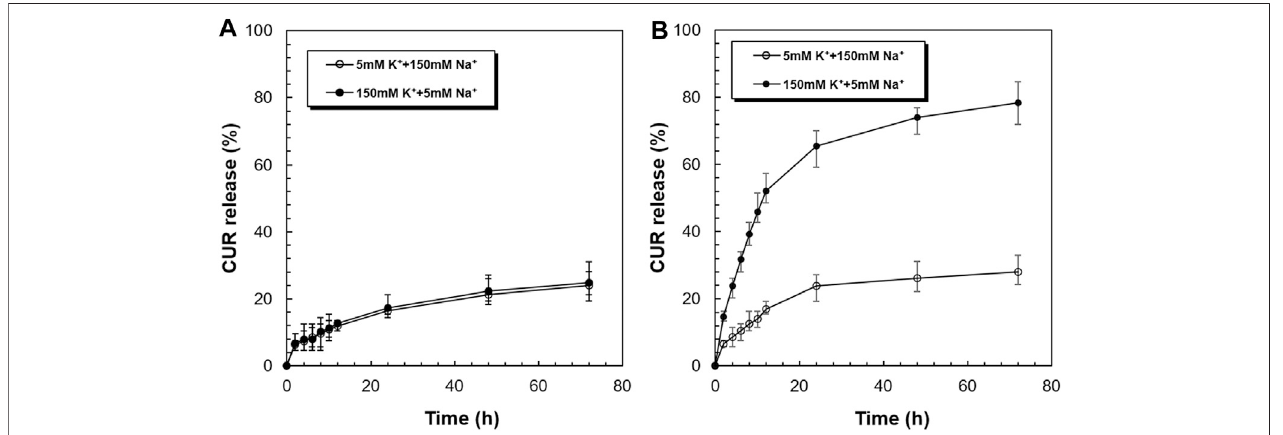
FIGURE 5 | K + -responsive controlled-release behaviors of CUR from CUR-PEG-DSPE micelles (A) and CUR-PNDB-DSPE micelles (B) in simulated extracellular and intracellular fl